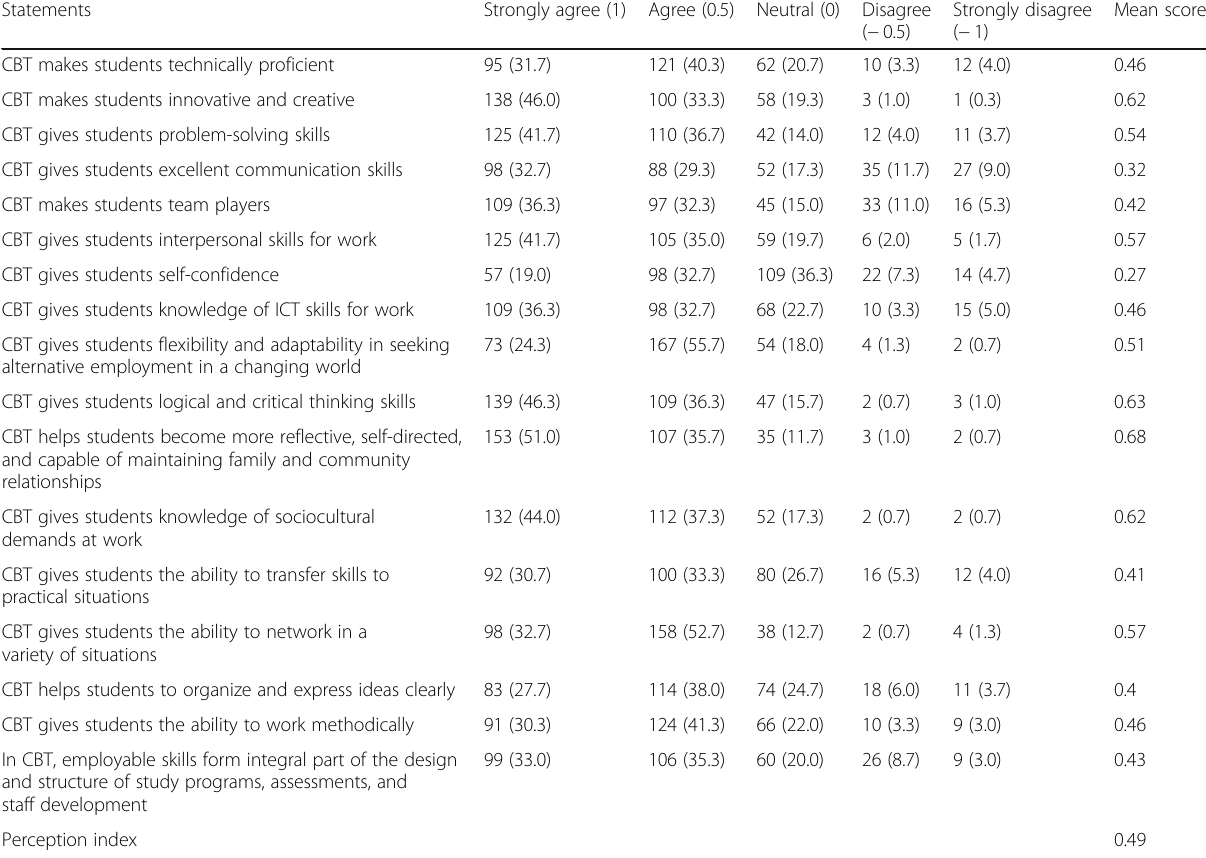
Table 4 Faculty ’ s perception on competences-based student-centered